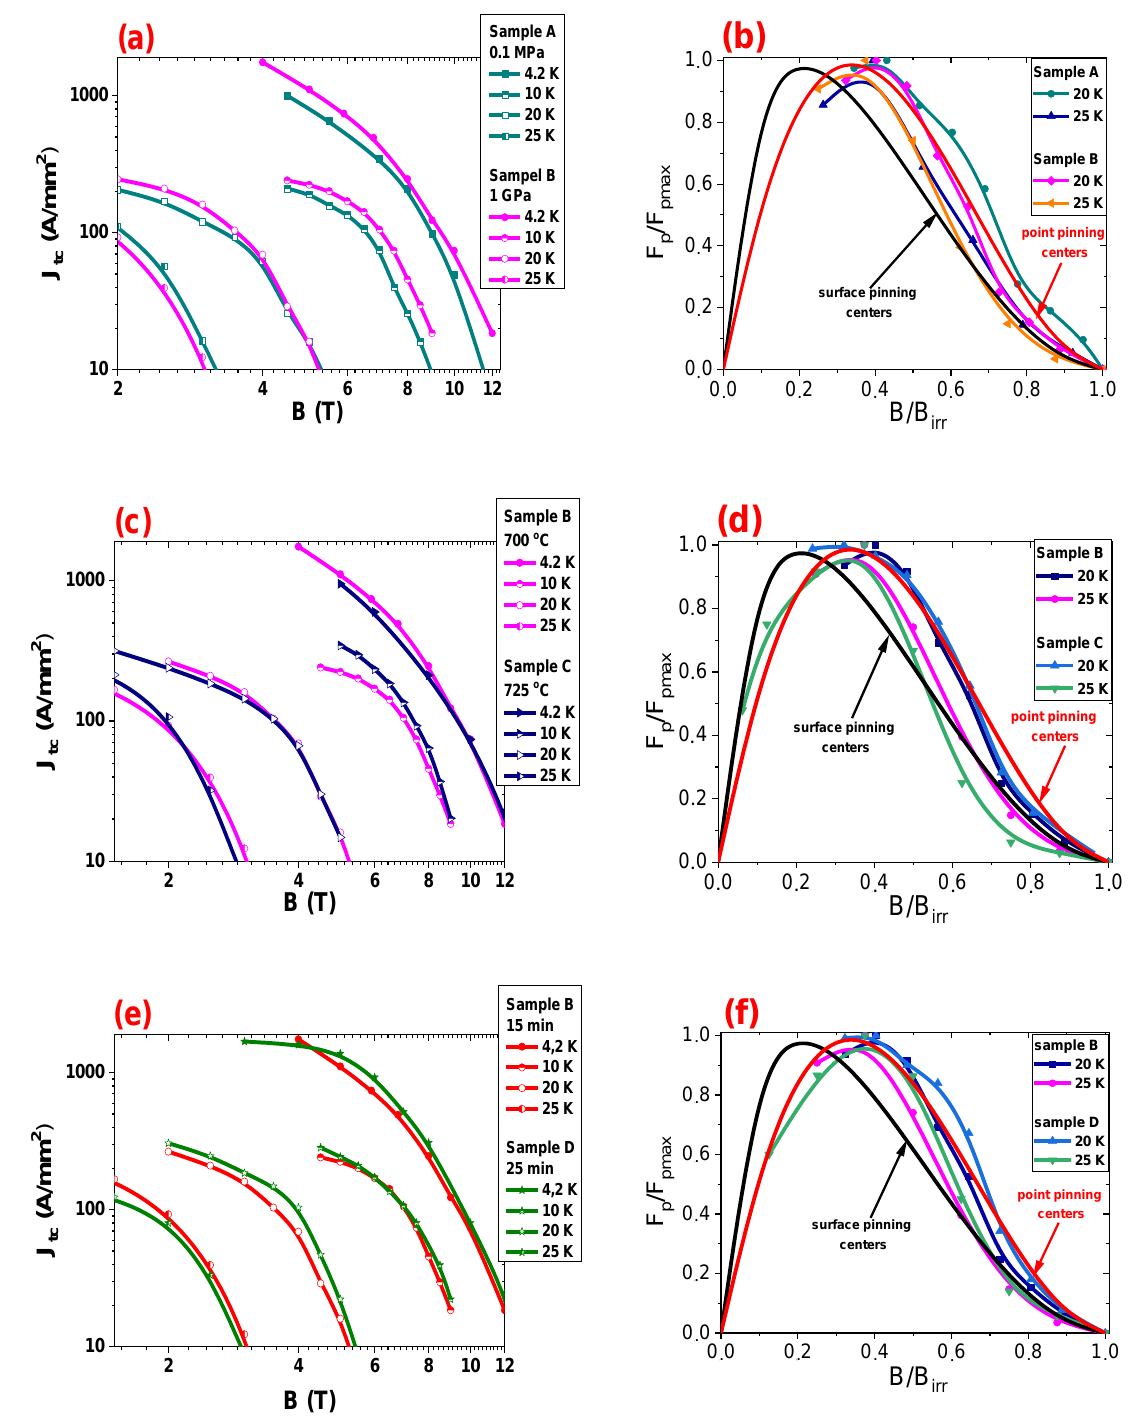
Figure 6. ( a , c , e ) The transport critical current density ( J tc ) as a function of the perpendicular magnetic field ( B ) at 4.2 K, 10 K, and 20 K for undoped MgB 2 wires with a 0.83 mm diameter. ( b , d , f ) The reduced pinning force depending on the reduced magnetic fields for undoped MgB 2 wires. The results presented in [51] (undoped MgB 2 wires with a diameter of 0.63 mm) and Figure 6a (undoped MgB 2 wires with a diameter of 0.83 mm) show that thermal treatment under high isostatic pressure significantly increases J tc at 20 K in undoped MgB 2 wires with a diameter of 0.63 mm. The measurements shown in [51] (undoped MgB 2 wires with a diameter of 0.63 mm) and Figure 6a (undoped MgB 2 wires with a diameter of 0.83